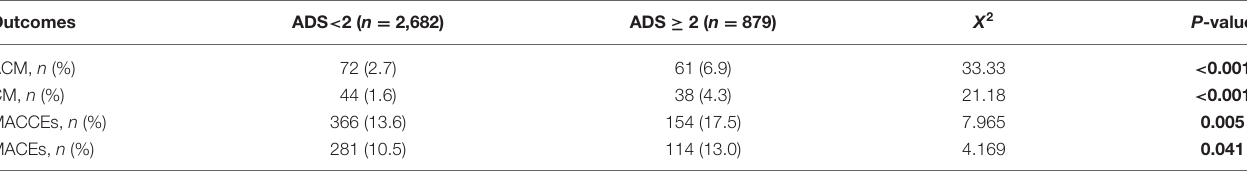
TABLE 2 | Outcomes comparison between groups.